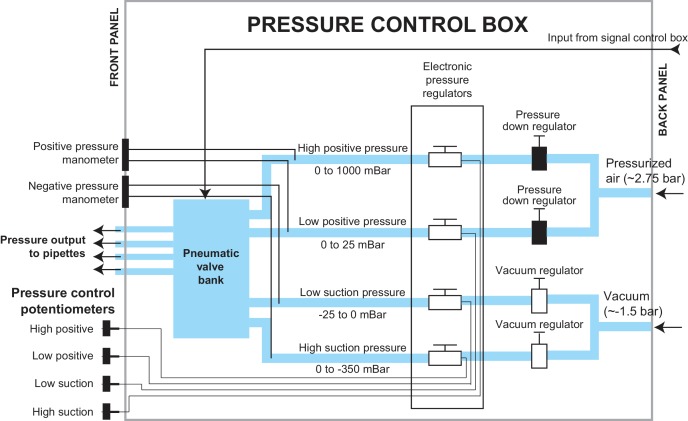
Schematic of the signal control box.Within the signal control box, an interface board was connected to the computer executing the multipatcher algorithm via a Universal Serial Bus (USB) datalink. Analog output channels on the interface board were used to send command voltage signals to the amplifiers. Analog input channels were used to read measurements taken from the patch amplifiers. BNC relays were controlled using digital Transistor-Transistor-Logic (TTL) signals to switch the command signal being sent to the patch amplifier between the analog outputs on the computer interface board and the analog outputs on the digitizer. TTL signals, and one analog voltage signal from the interface board were also sent to the pressure control box.